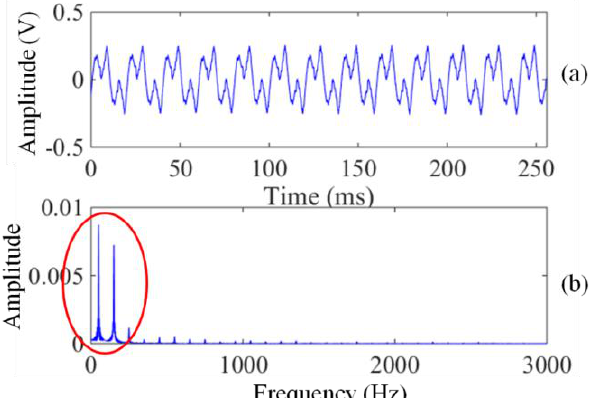
Figure 2. The power harmonic noise waveforms. ( a ) Time domain waveform; ( b ) Frequency domain waveform.